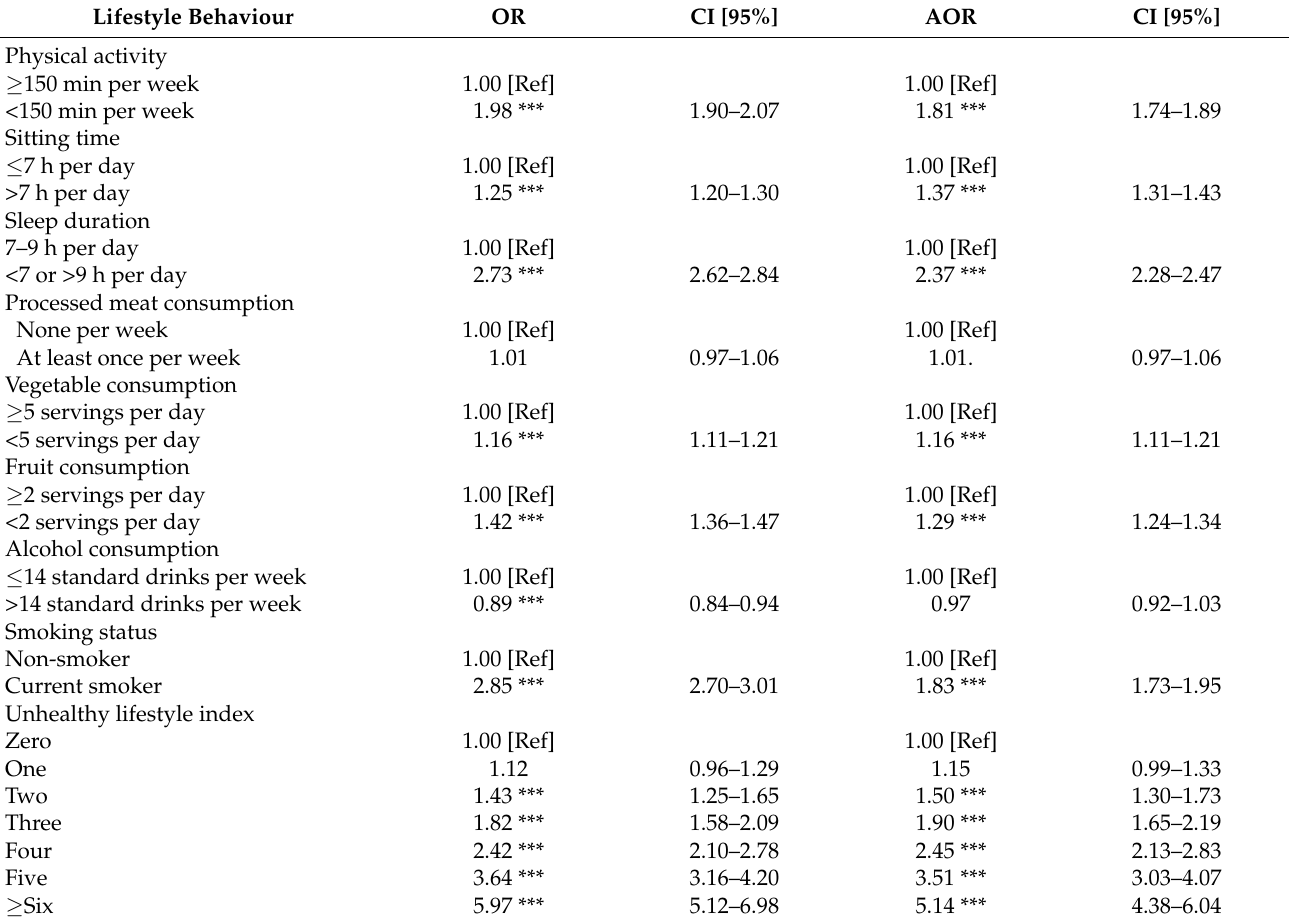
Table 3. Baseline odds of psychological distress with lifestyle behaviours and unhealthy lifestyle index using unadjusted odds ratios (OR) and adjusted odds ratios